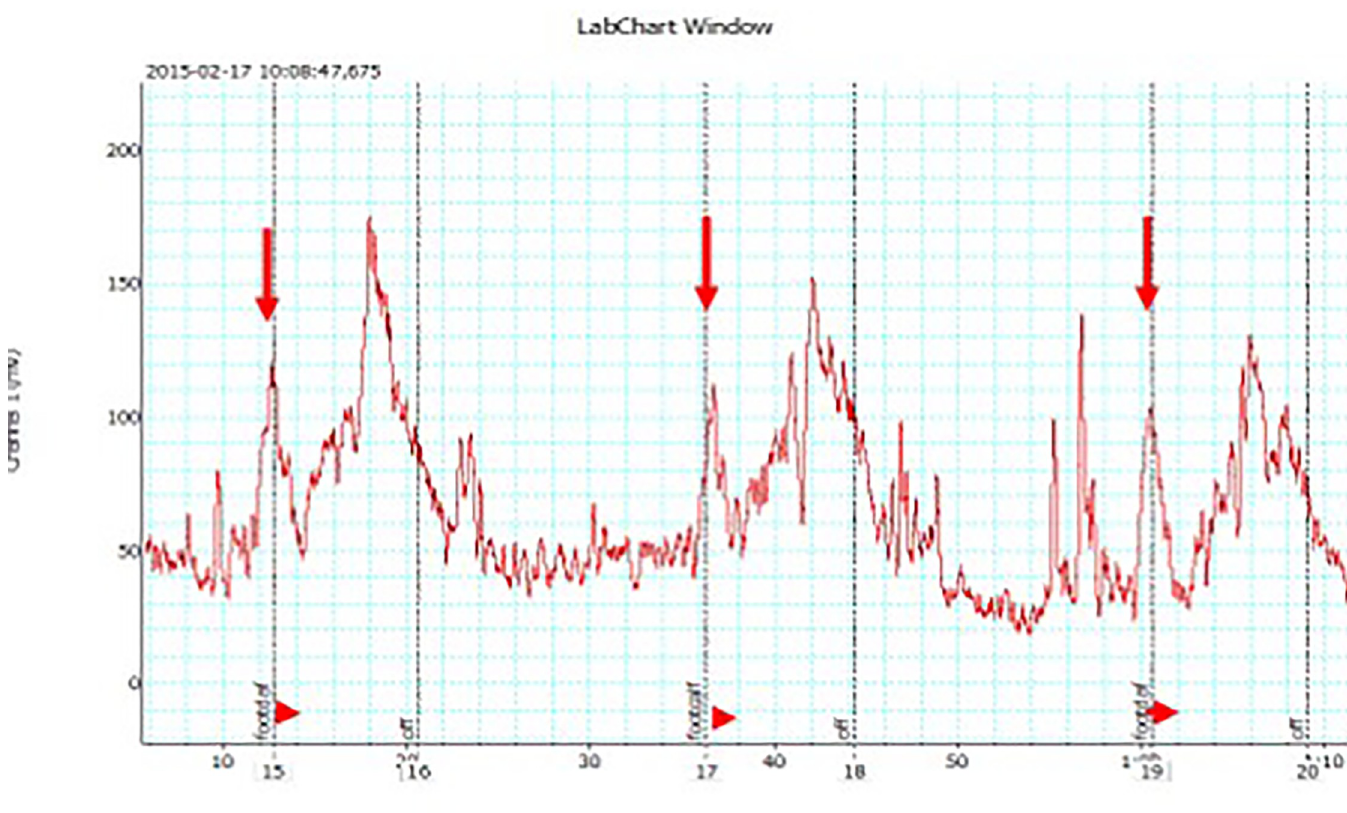
Fig 3. Laser Doppler recording of the big toe capillary flow velocity (in millivolts) during the designed arterial assist pump (arrows point 4–6 sec inflation of foot- calf chambers) in a patient with multifocal calf arteries occlusions. The peak is followed by a short drop and then increase in flow returning to control values during the 16 sec (off) without